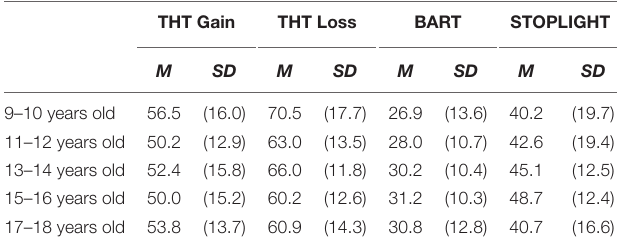
TABLE 2 | Percentage of Risky Decisions (SD) in the four risk-taking settings as a function of age group. THT Gain THT Loss BART